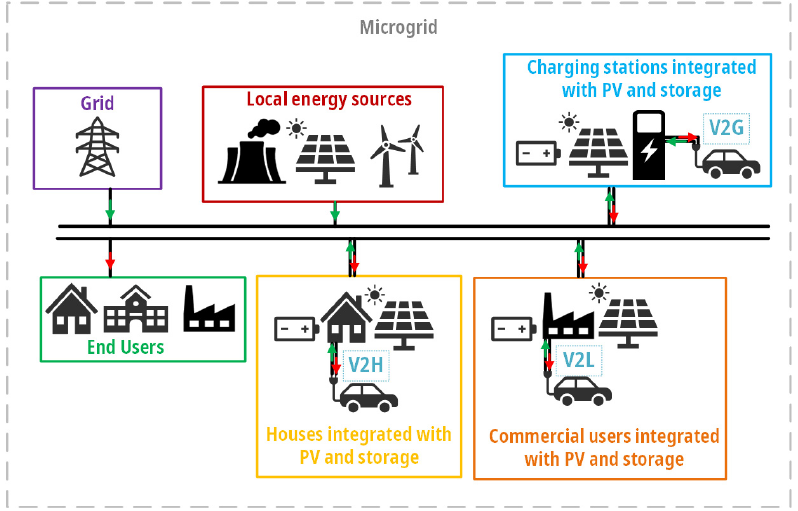
Figure 1. Integration of the EV in the local microgrid with possible V2X service provision.